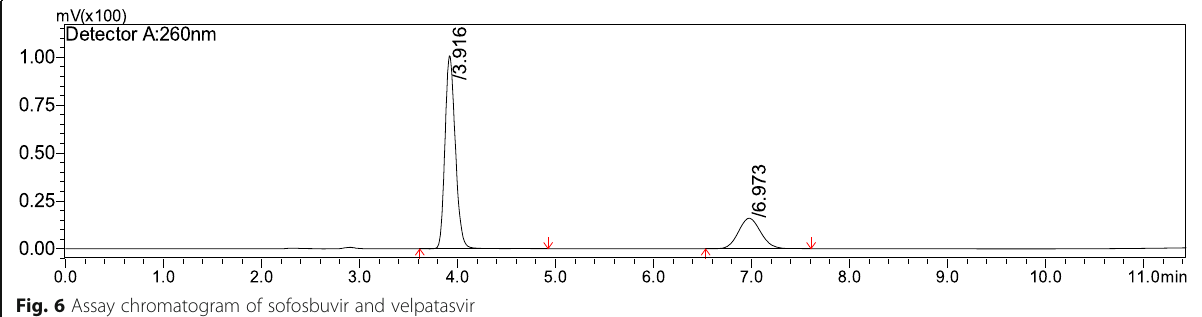
Fig. 6 Assay chromatogram of sofosbuvir and velpatasvir